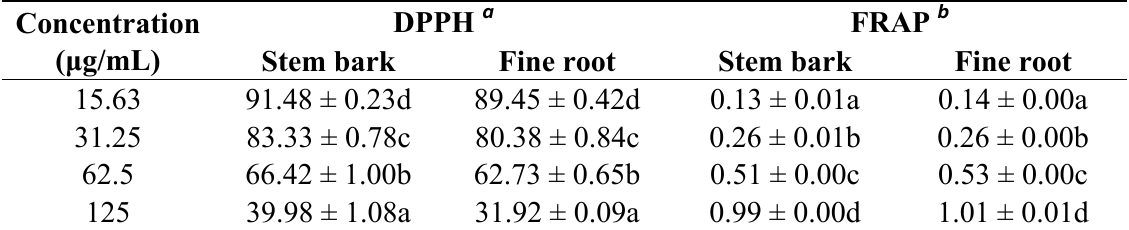
Table 3. Concentration effect of condensed tannins from stem bark and fine root of C. equisetifolia on their free radical scavenging activity (DPPH) and reducing capacity (FRAP) (n = 3).